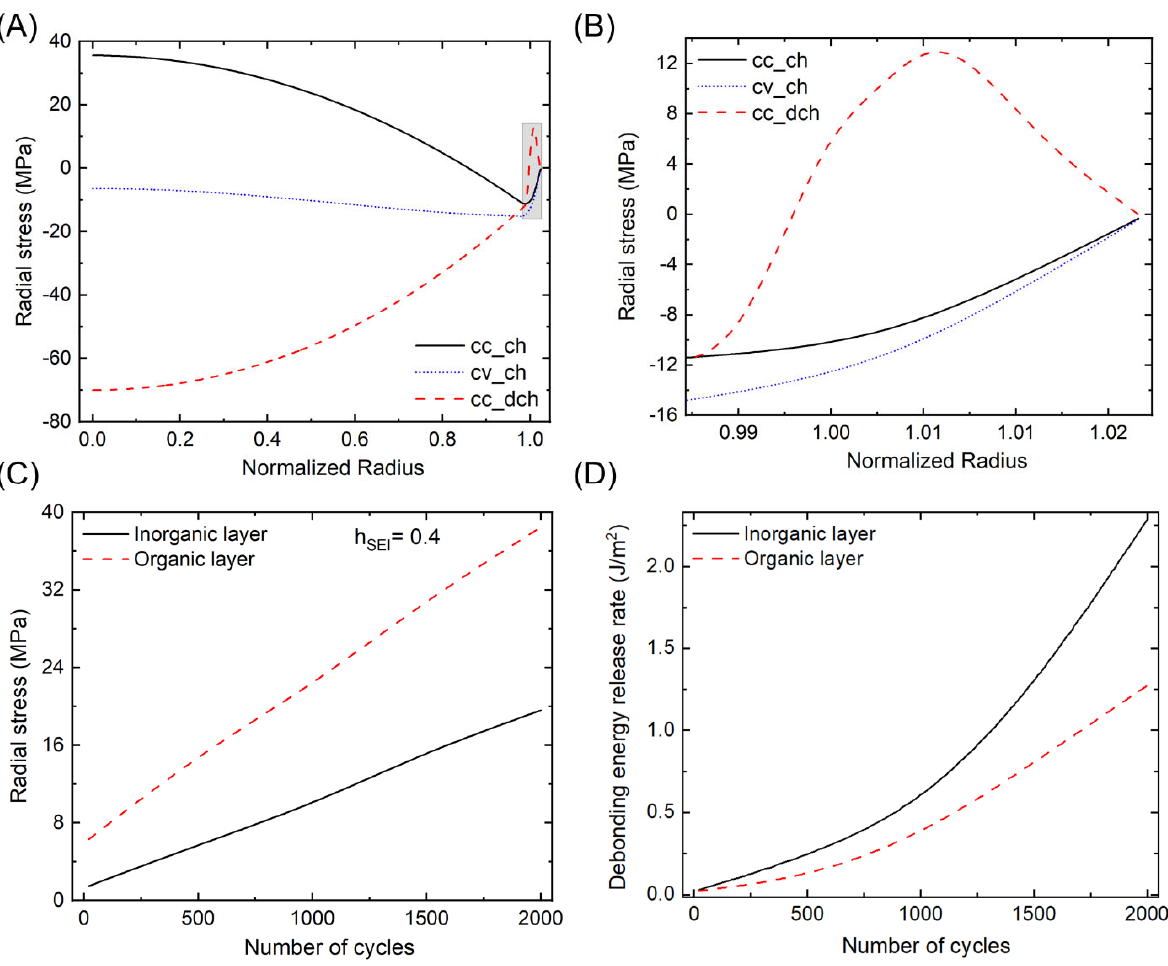
Figure 7. ( A ) Radial stress profile along the radius of particle at the end of constant current charge (cc_ch), constant voltage charge (cv_ch), and discharge (cc_dch). ( B ) Magnified view of the parti- cle/SEI interface and SEI layers. The magnified area is shown in ( A ). ( C ) Evolution of radial stress in the inorganic and organic SEI layer interface (h SEI = 0.4). ( D ) Evolution of debonding energy release rate in the SEI layers (h SEI = 0.4).